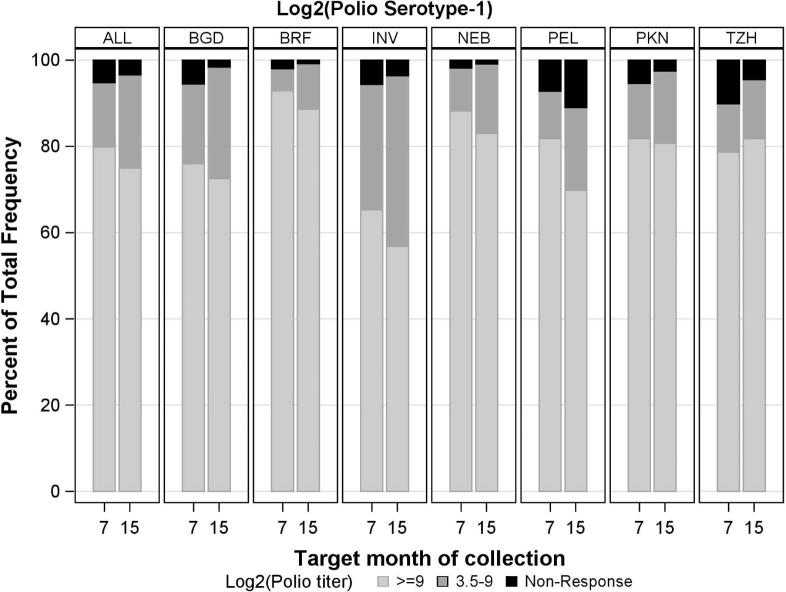
Poliovirus serotype 1 neutralization titer distributions by site and scheduled month of blood collection. Site locations; Dhaka, Bangladesh (BGD), Foratleza, Brazil (BRF); Vellore, India (INV); Bhaktapur, Nepal (NEB); Loreto, Peru (PEL); Naushero Feroze, Pakistan (PKN); Haydom, Tanzania (TZH).